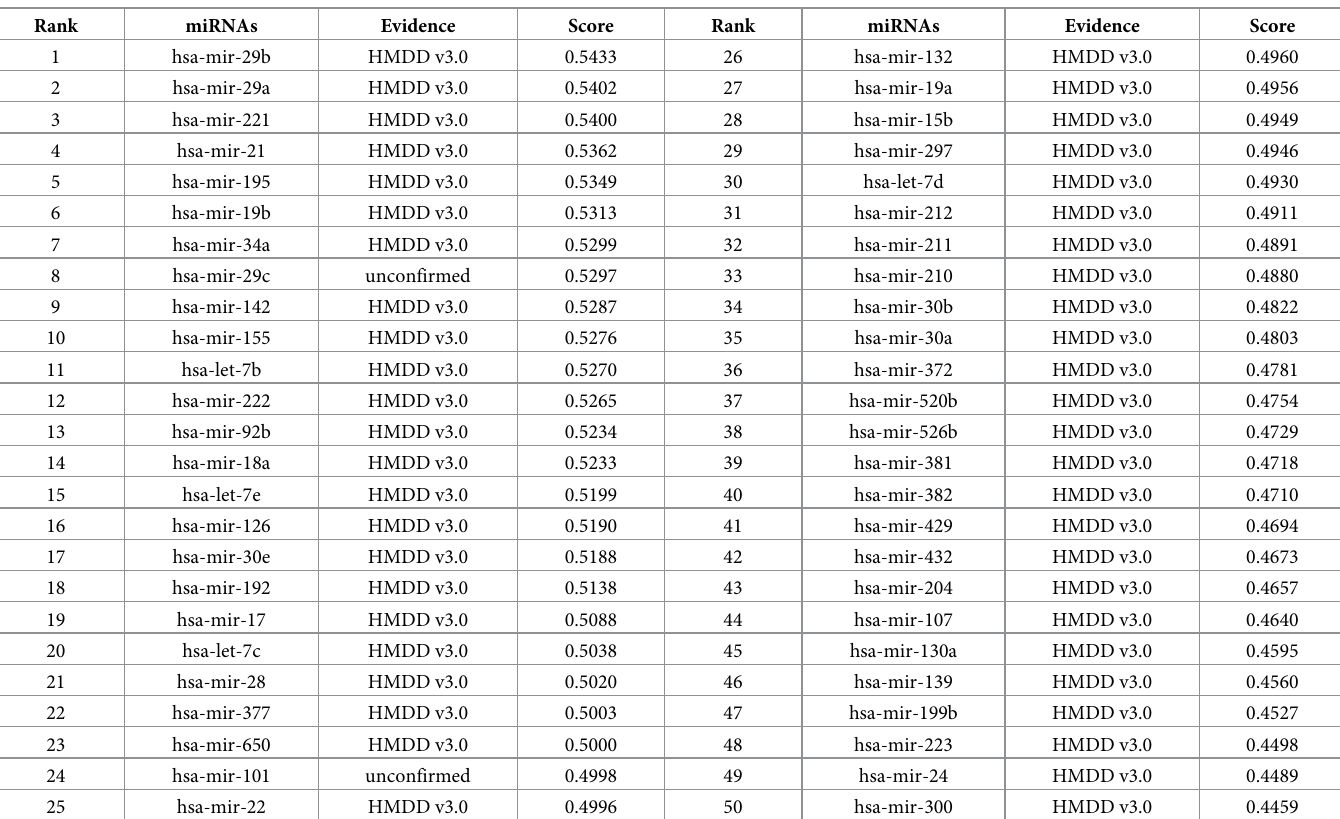
Table 5. Validation results of predicted associations for heart failure as an unknown